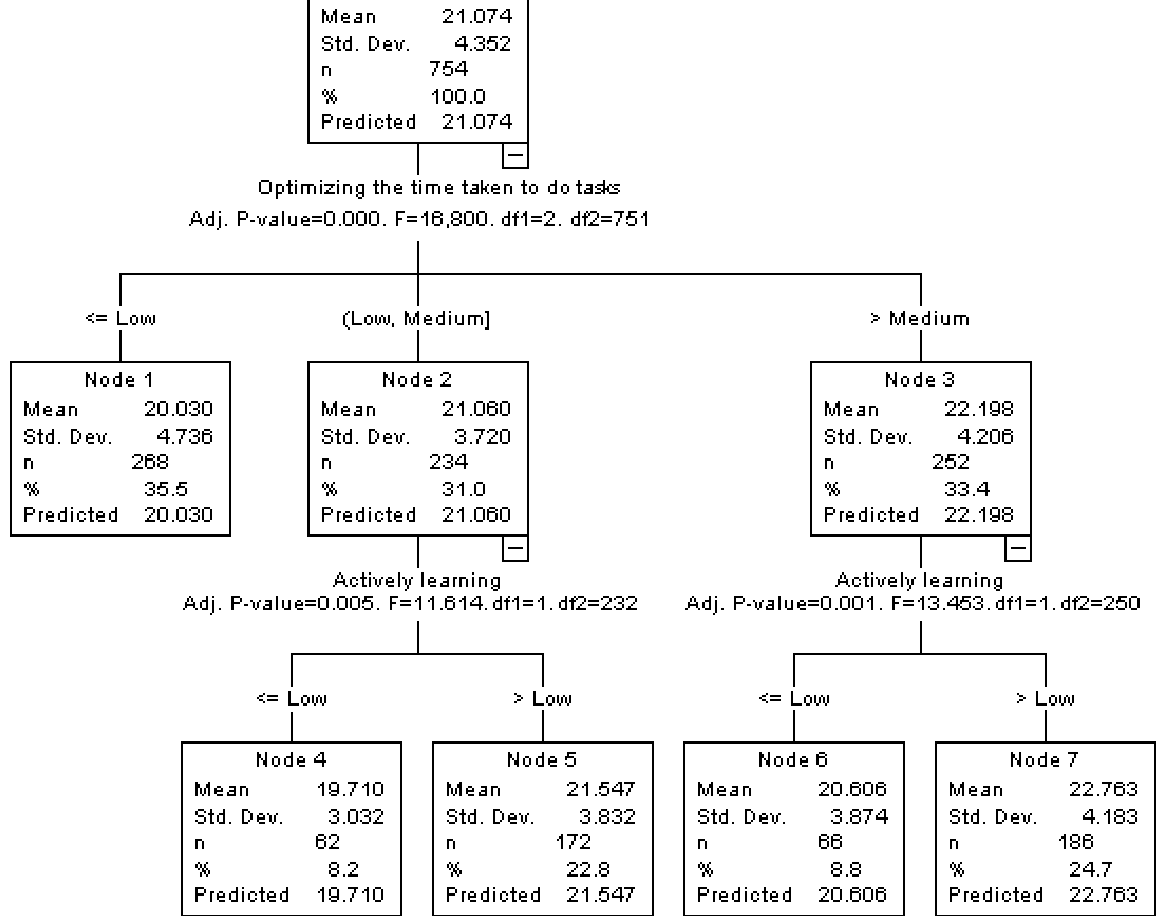
Figure 2. Classification tree for Achievement Strategy.